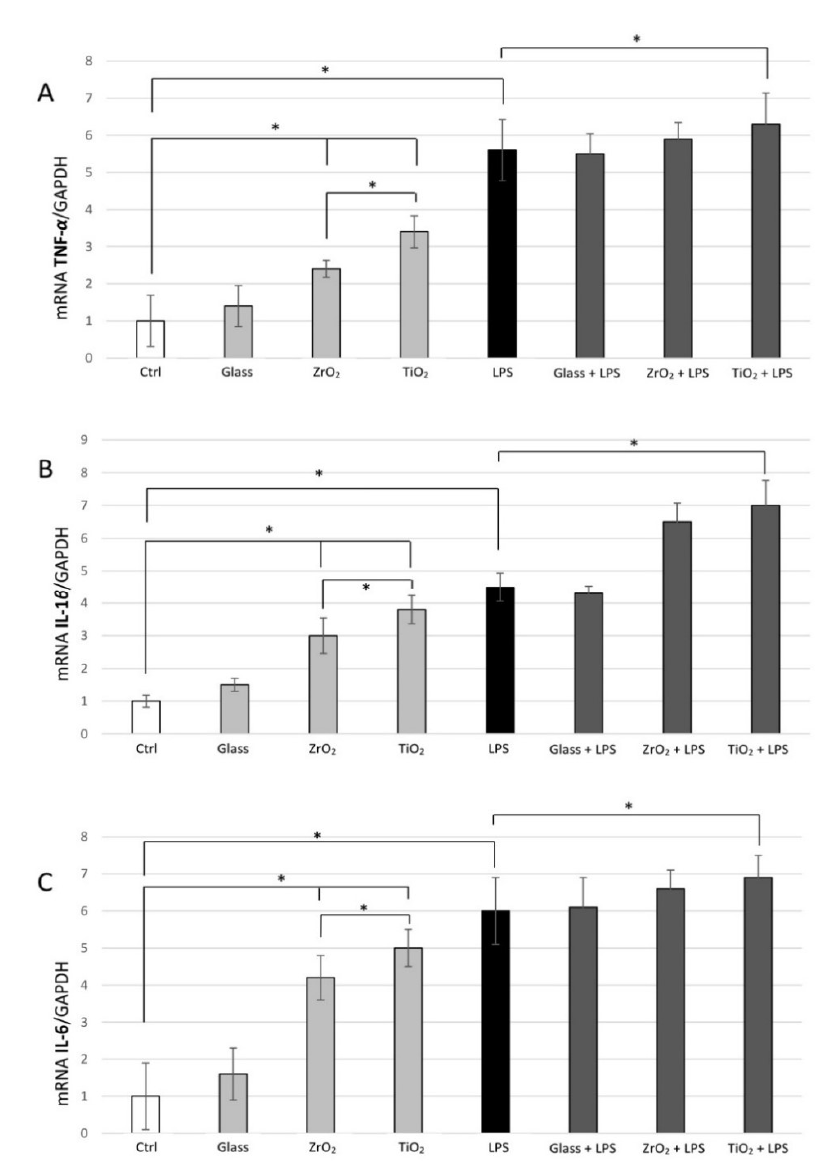
Figure 3. Particle and sterile LPS inflammation-induced pro-inflammatory gene expression in THP-1. Expression of mRNA for inflammatory cytokines in macrophages challenged with titanium (TiO 2 ), zirconia (ZrO 2 ) and glass particles under sterile inflammation (LPS = 1 µg/mL) in 48 h. qRT-PCR, with normalization to GAPDH using the Ct method analysis, are shown as means ± SD. ( A ) TNF-α , ( B ) IL-1β , ( C ) IL-6 . The symbol * indicates a statistically significant increase in cytokines’ mRNA expression in comparison to non-challenged macrophages. * p ≤ 0.05.